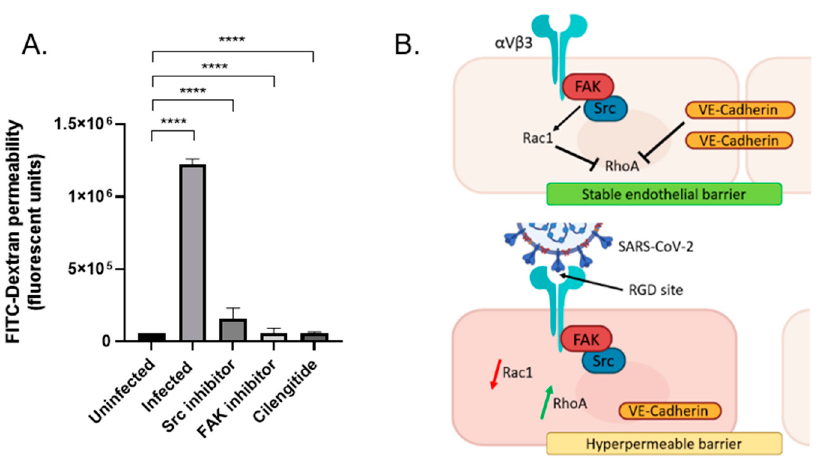
Figure 4. Vascular permeability induced by SARS-CoV-2 infection is mediated by endothelial integrin α V β 3. ( A ) Pharmacological inhibitors of Src (SU6656, 1 µM), FAK (PF562271, 1 µM), and integrin α V β 3 (Cilengitide, 0.0005 µM) incubated with SARS-CoV-2 infected endothelial cells. **** p < 0.0001, One-way ANOVA. Values are mean ± S.E.M., n = 3. ( B ) Schematic depiction of the proposed pathway of integrin engagement with spike protein and subsequent signaling cascade lead- and Rac1 regulate and maintain low RhoA levels through FAK and Src signaling. Rac1 and RhoA signaling is tightly controlled via integrin engagement with an extracellular ligand. Bottom panel